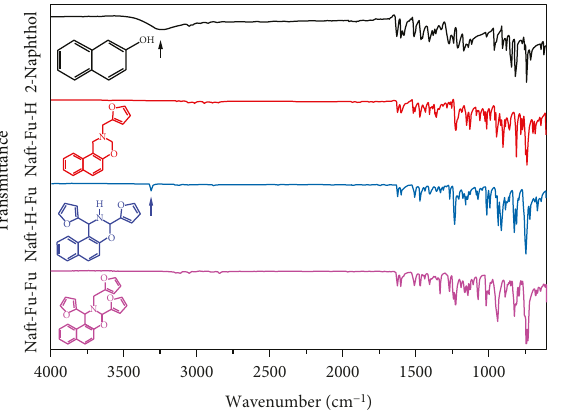
Figure 4: FTIR spectra of the naphthoxazines in the fi ngerprint